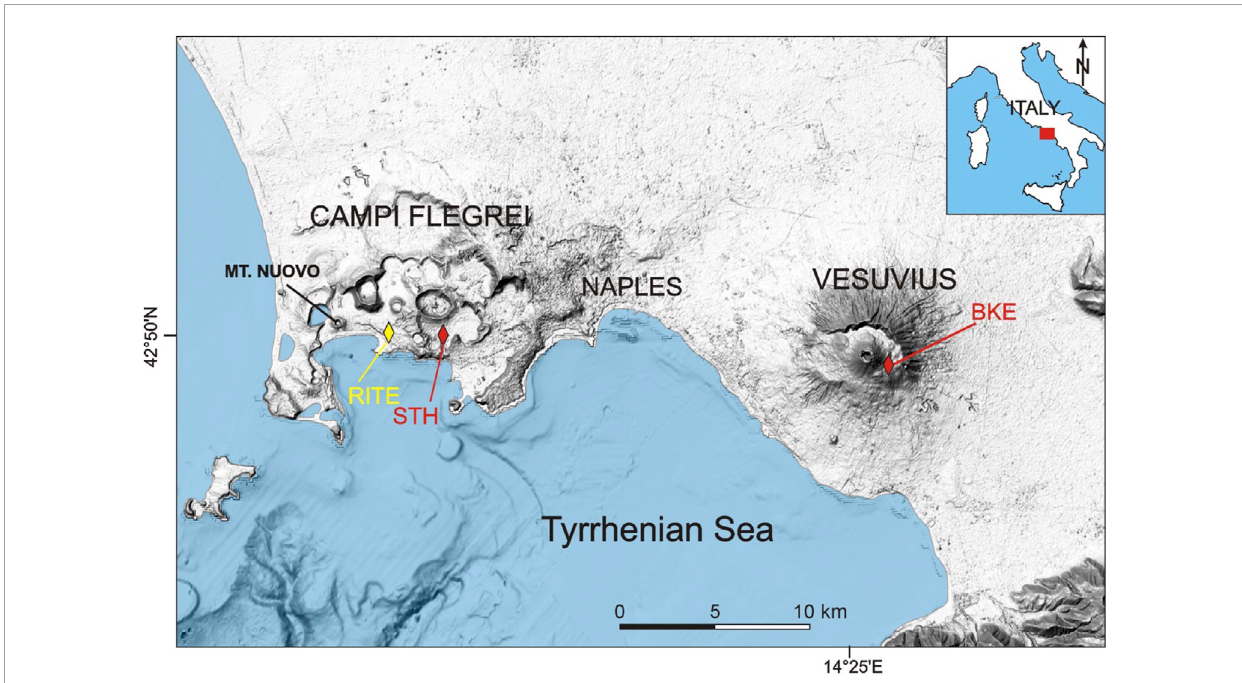
FIGURE 1 Digital Elevation Model of the Campi Flegrei and Somma-Vesuvius volcanic areas illustrating the position of the seismic and CGPS stations used in the present study. The red diamonds show the location of the Osservatorio Vesuviano - INGV seismic stations on the flanks of Somma-Vesuvius (BKE) and in the Campi Flegrei Caldera area at Pozzuoli (STH). The yellow diamond indicates the location of the RITE (Rione Terra-Pozzuoli) CGPS station where, starting from November 2005, the largest Campi Flegrei uplift was measured. The last Campi Flegrei eruption, in 1538 AD, produced the Monte Nuovo crater, which is located in the western sector of the Campi Flegrei